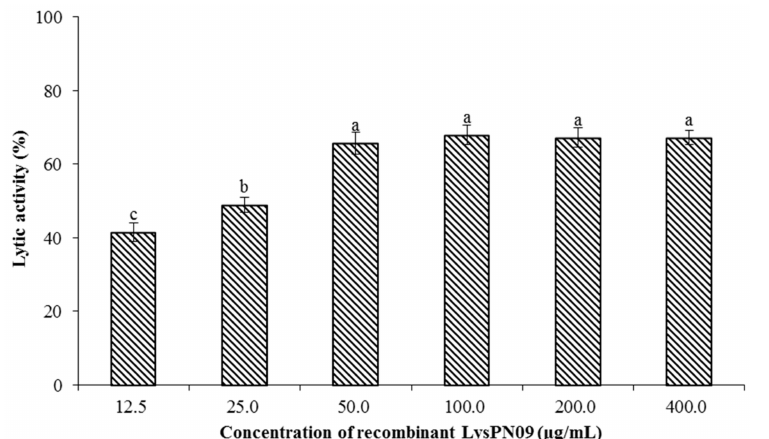
Figure 6. The lytic activity of different concentrations of LysPN09 on the Pseudomonas syringae pv. actinidiae (Psa) strain SCJY02-1 used as the host bacterium. LysPN09 concentrations of 12.5, 25.0, 50.0, 100.0, 200.0, and 400.0 µ g/mL were used. The means and standard deviations of three independent assays are shown. Shared letters above bars indicate no statistical difference among groups ( p > 0.05) and different letters above bars indicate a statistically significant difference ( p <